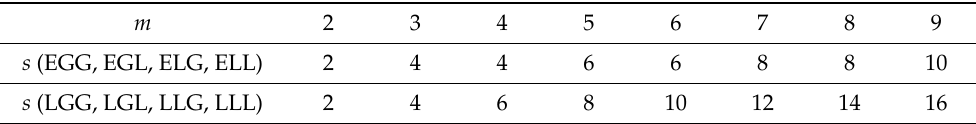
Table 3. Numerical convergence order of the eight